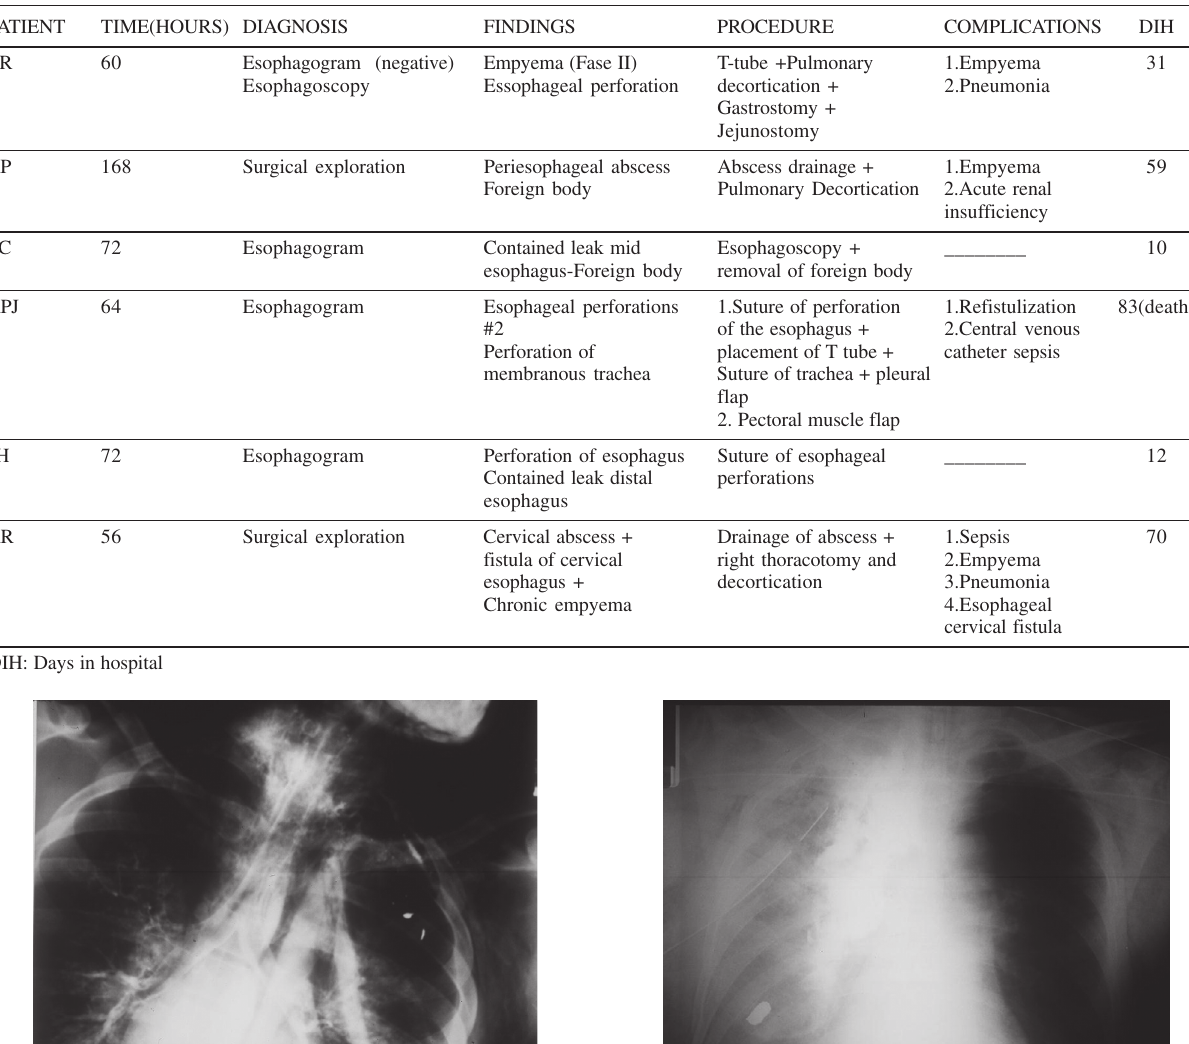
Table 2 - Delayed Treatment